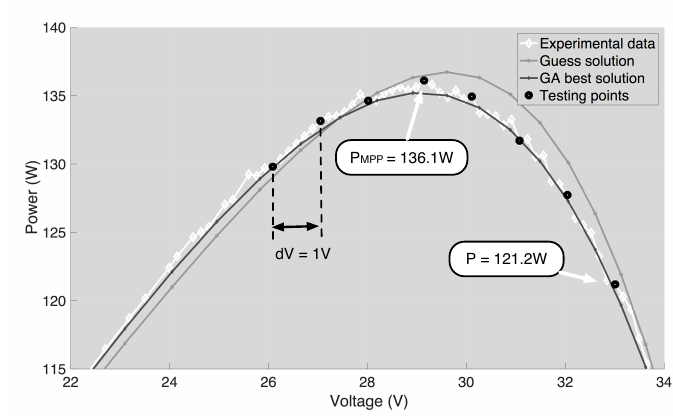
Figure 7. Zoom of the P-V photovoltaic curves for Test